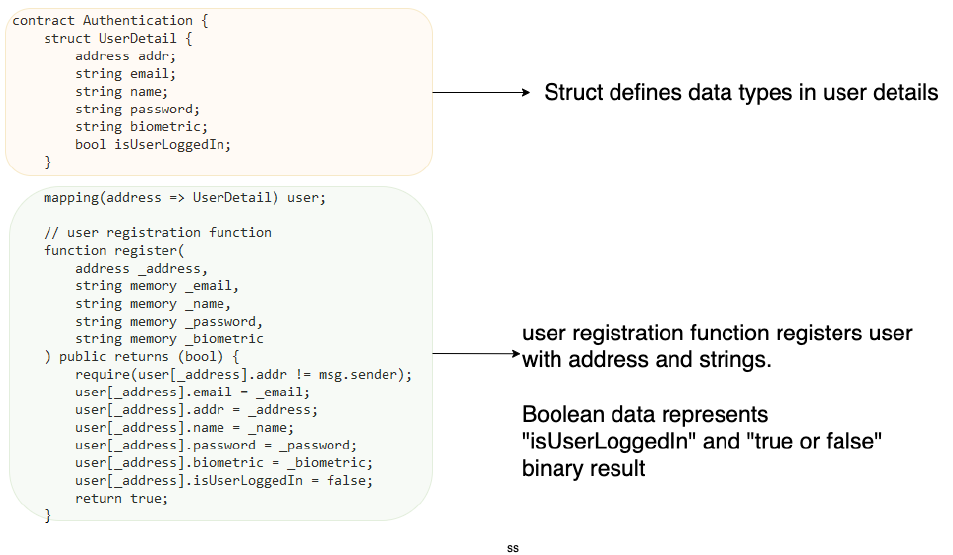
Figure 4. An example of smart contract code for user